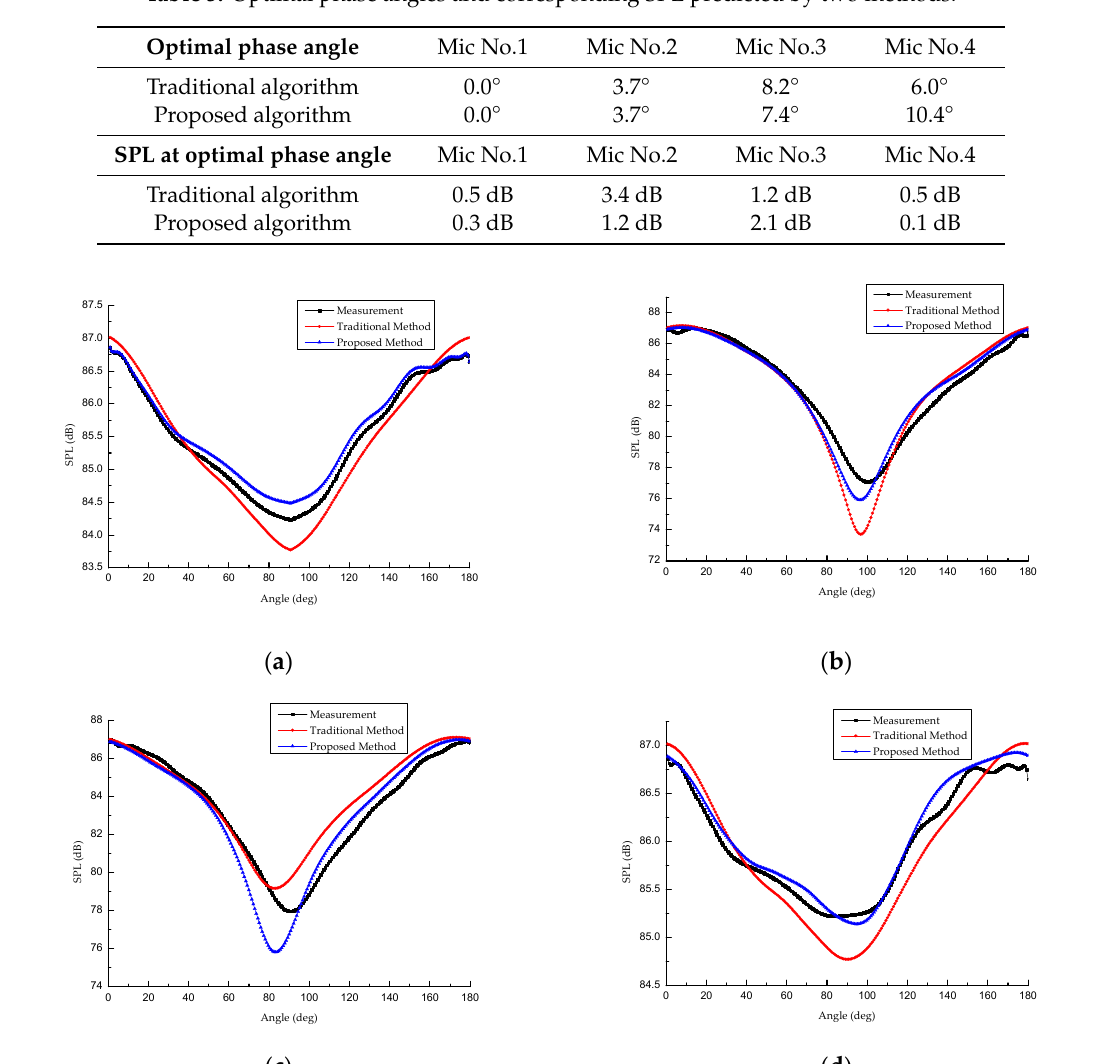
Table 3. Optimal phase angles and corresponding SPL predicted by two methods.